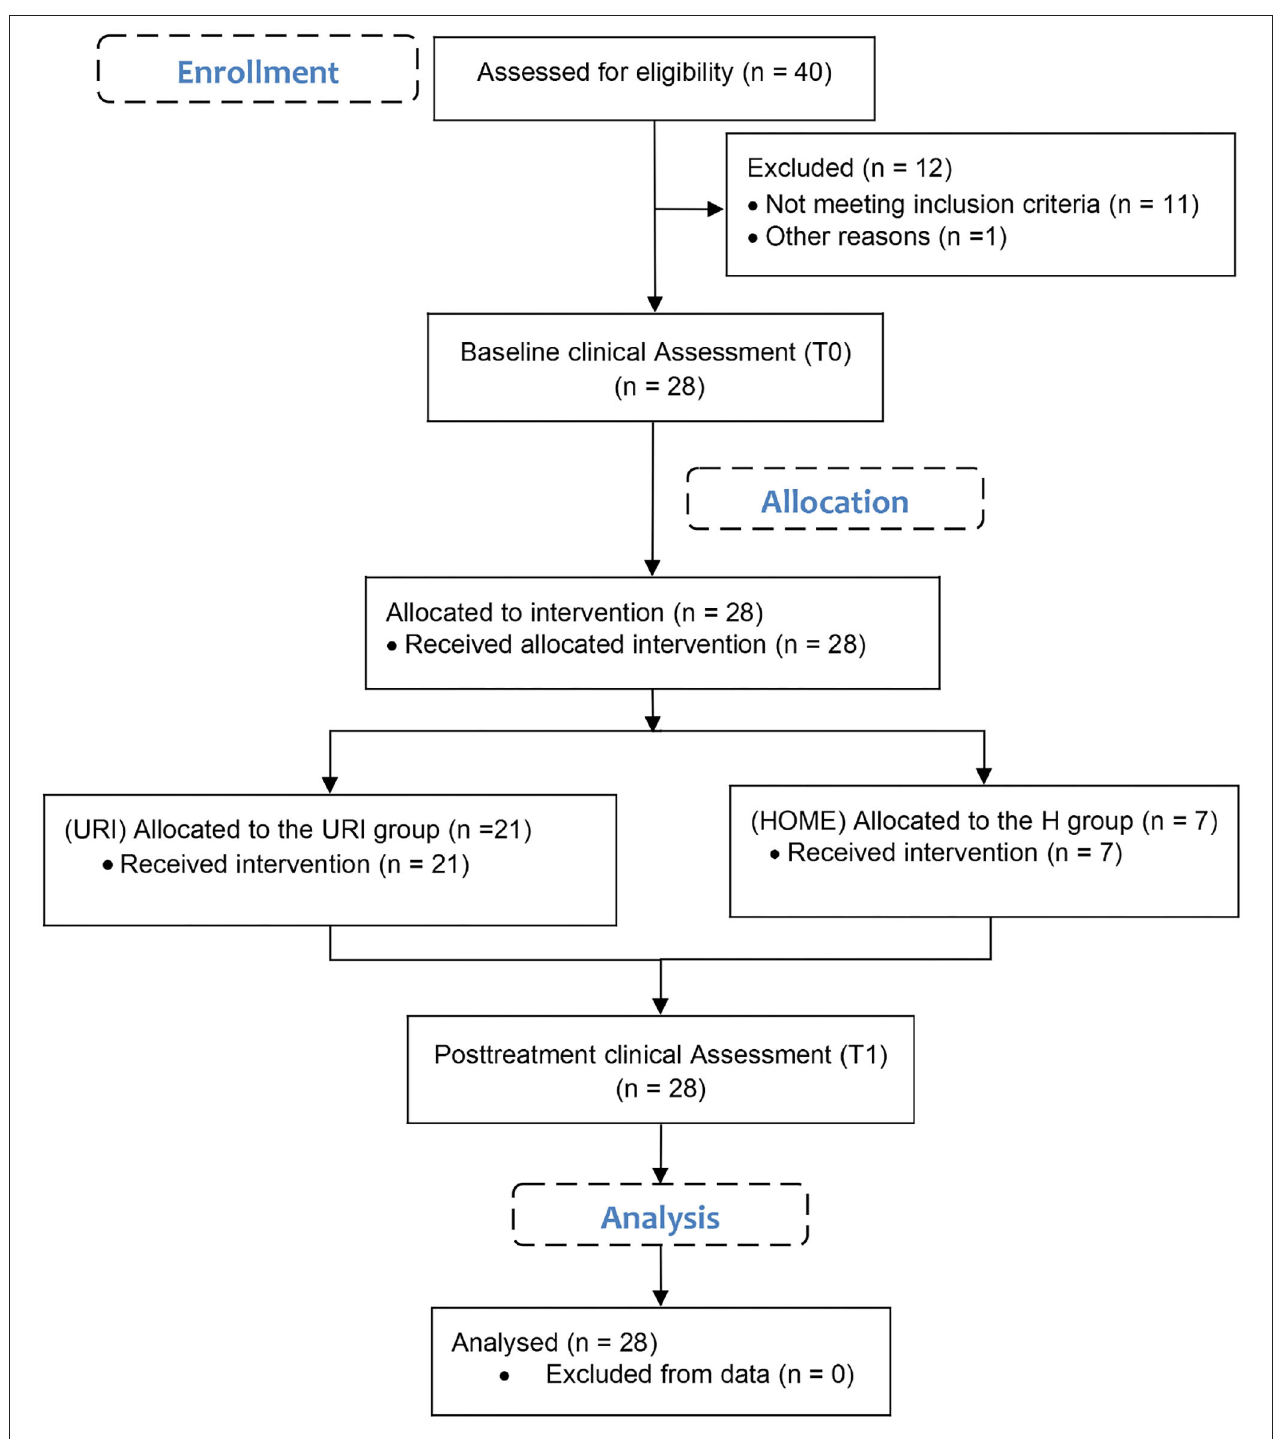
FIGURE 1 | CONSORT flow diagram. data synchronization occurring after the accomplished session (16). The client software was running on the bare-bone computer (Intel NUC i7, Win10 OS) and was designed and programmed in the Unity3D (Unity Technologies, CA, USA) environment. The